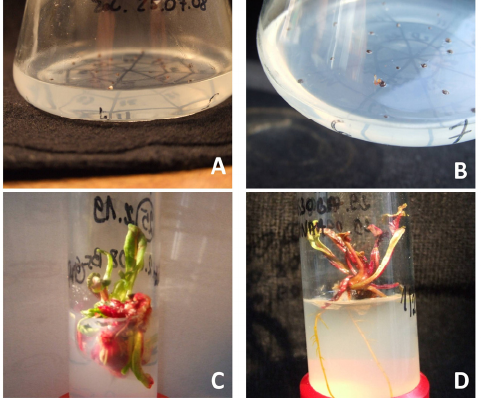
Figure 1. The following stages of regeneration of red beet plants from gynogenetic embryos in in vitro cultures of cultivar “Czerwona Kula”: ( A )—gynogenetic embryo in ovule cultures, ( B )—growing gynogenetic embryo in ovule cultures, ( C )—shoots multiplication obtained in ovule cultures, ( D )—a plant obtained by regeneration from gynogenetic embryos. Table 2. Influence of the composition of the B5 induction medium on the effectiveness of gynogen ‐ esis in red beet “Czerwona Kula”.